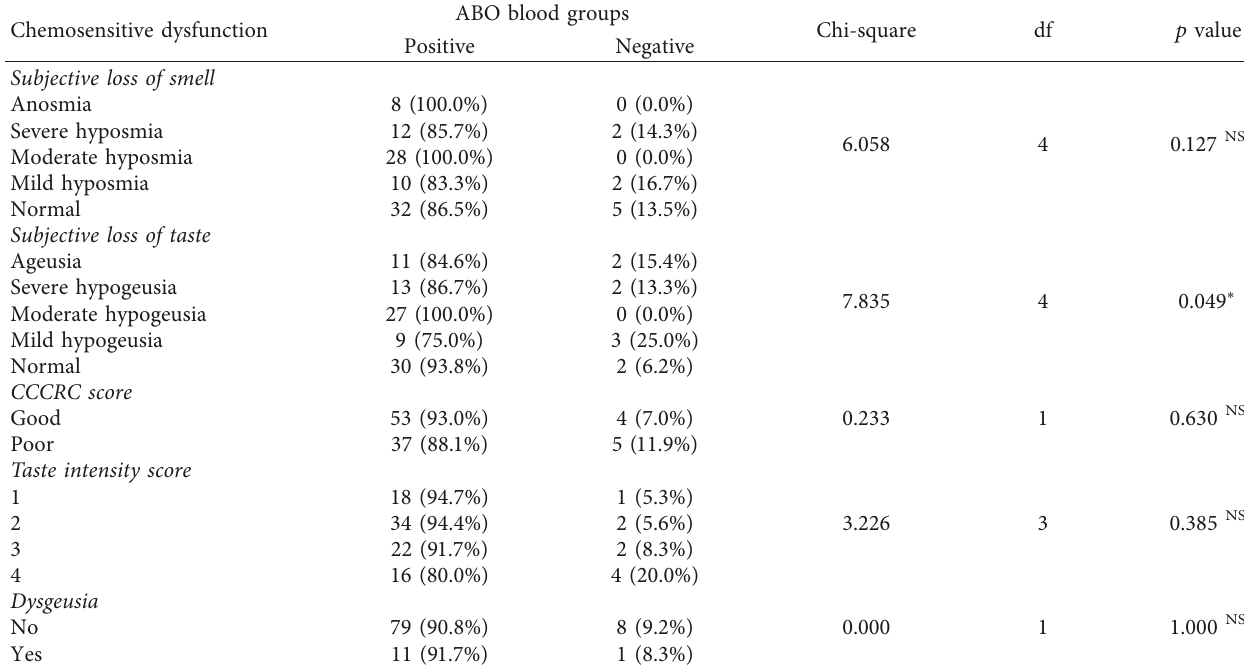
Table 4: Chi-square test of association between positive and negative blood groups and chronic chemosensitive dysfunction in post- COVID-19 patients (fishers exact test).